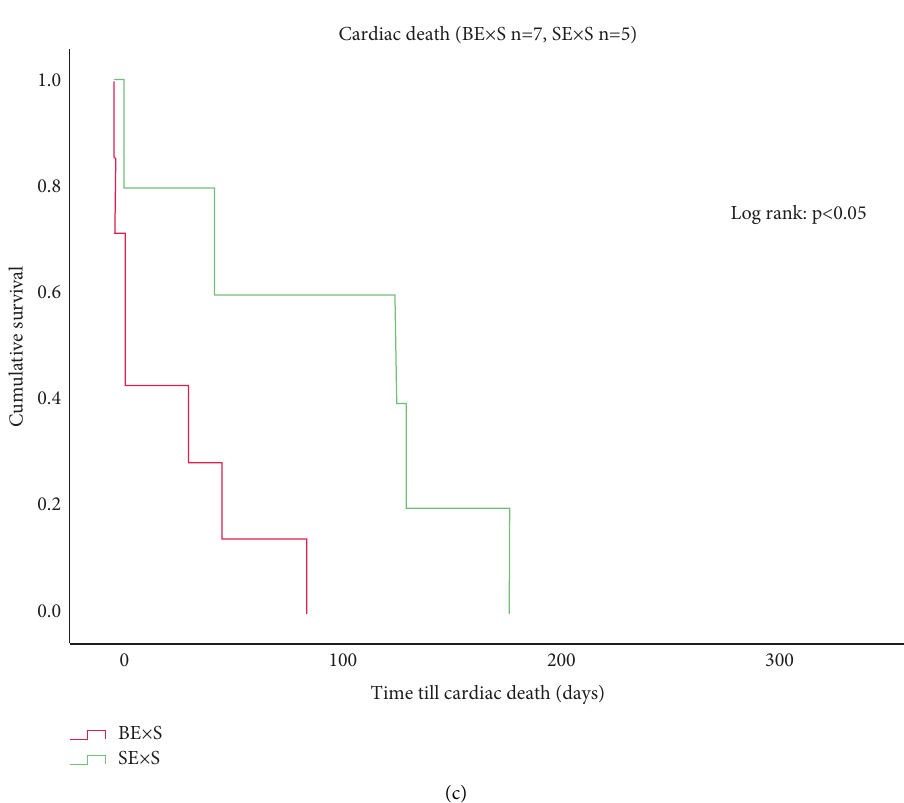
Figure 5: (a) Kaplan–Meier curve for cumulative MACE-free survival within 30 days in BExS and SExS patient groups (log rank p < 0 . 05). SExS � self-expanding drug eluting stent; BExS � balloon expanding drug eluting stent. (b) Central illustration: Kaplan–Meier curve for cumulative MACE-free survival within one year in BExS and SExS patient groups (log rank p < 0 . 02). SExS � self-expanding drug eluting stent; BExS � balloon expanding drug eluting stent. (c) Kaplan–Meier curve for cardiac death within 12 months in the BExS and SExS patient groups (log rank p < 0 . 05). SExS � self-expanding drug eluting stent; BExS � balloon expanding drug eluting